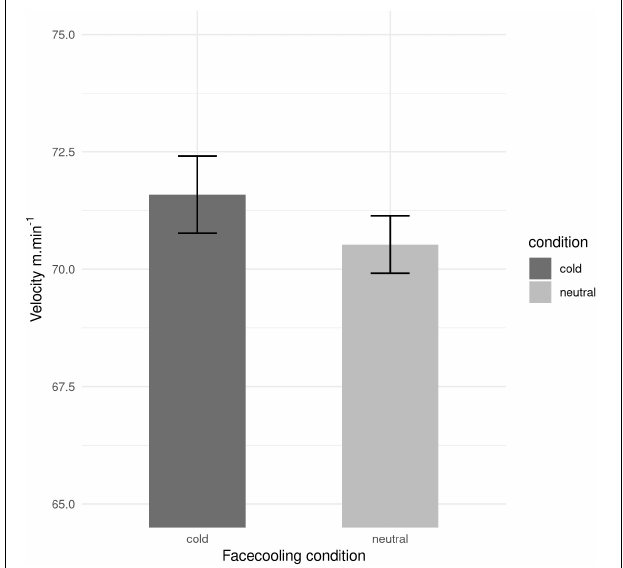
FIGURE 1 | Velocity of swimmer in the both conditions: cold face cooling and neutral face cooling. Mean values and SD are